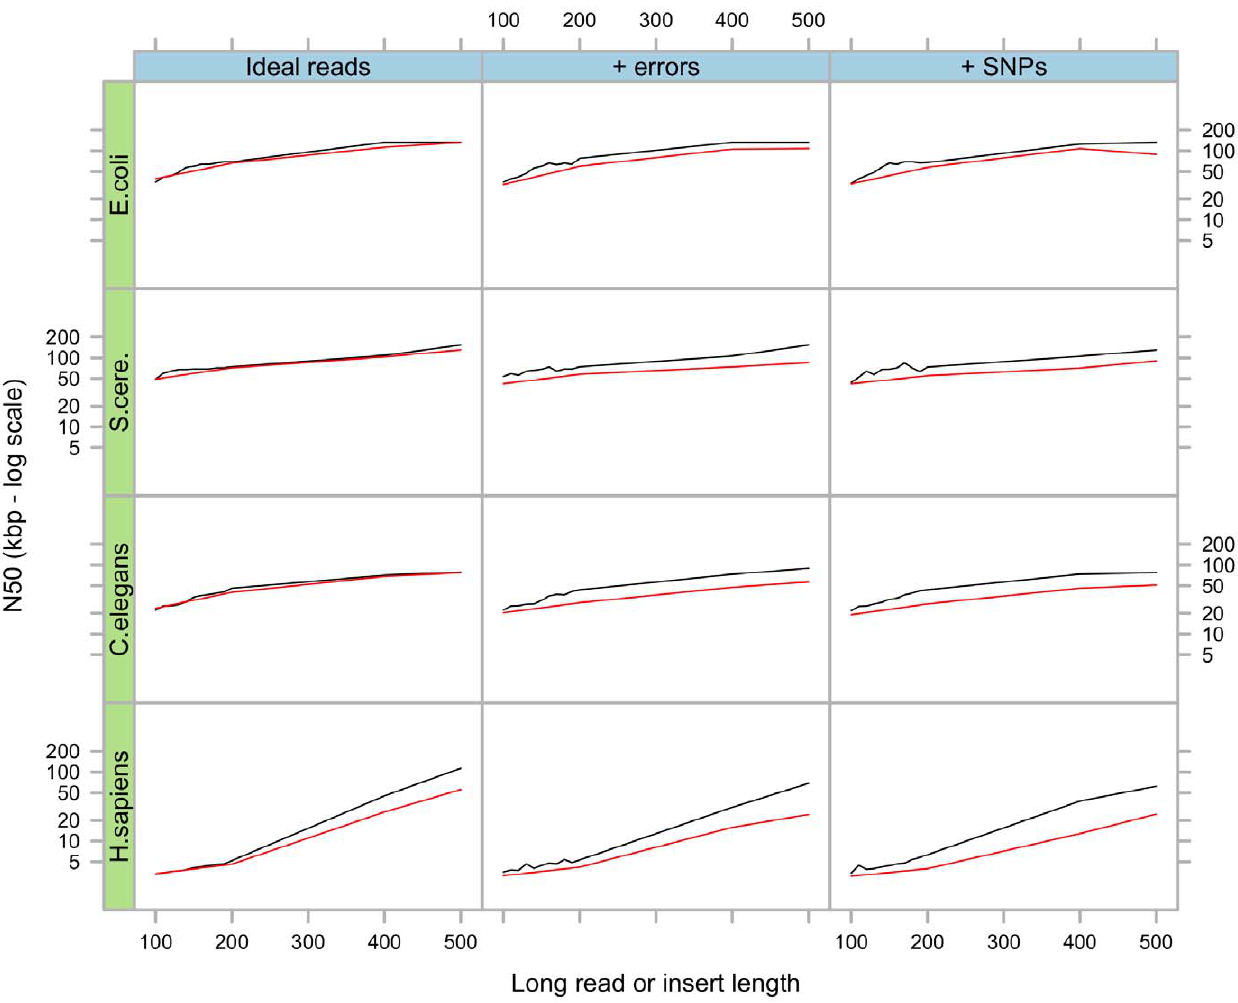
Figure 5. Comparison of the Rock Band and Pebble methods. The red and black curves represent the final scaffold N50 after the execution of the Rock Band or Pebble algorithms respectively, as a function of long read or insert length, in four different species and three different simulations scenarios, as described in figures 3 and 4.